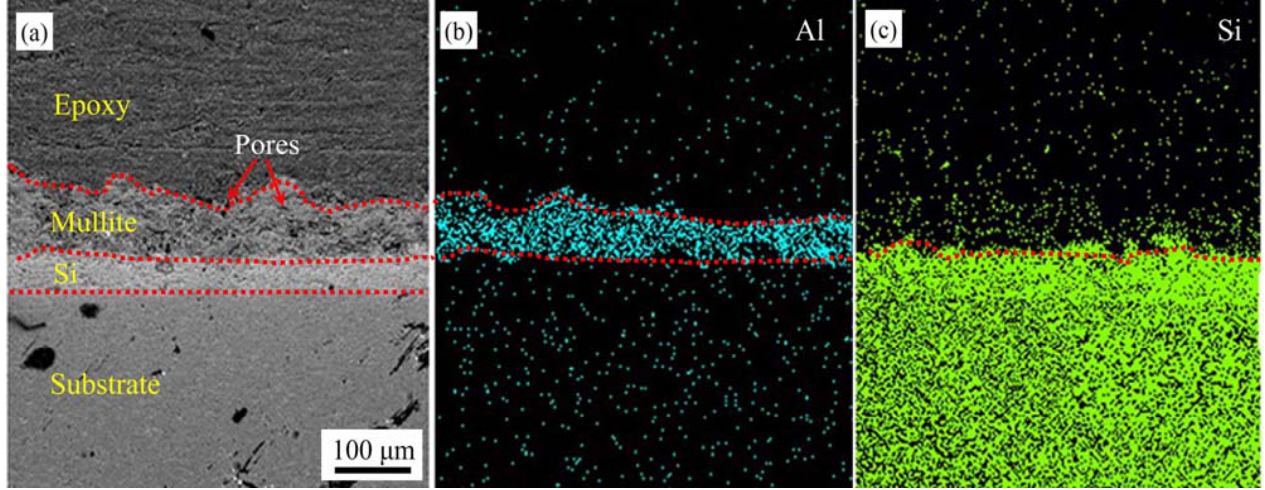
Figure 9. ( a ) Cross ‐ section of as ‐ sprayed EBC, ( b ) element distribution map of Al, and ( c ) element distribution map of Si. distribution map of